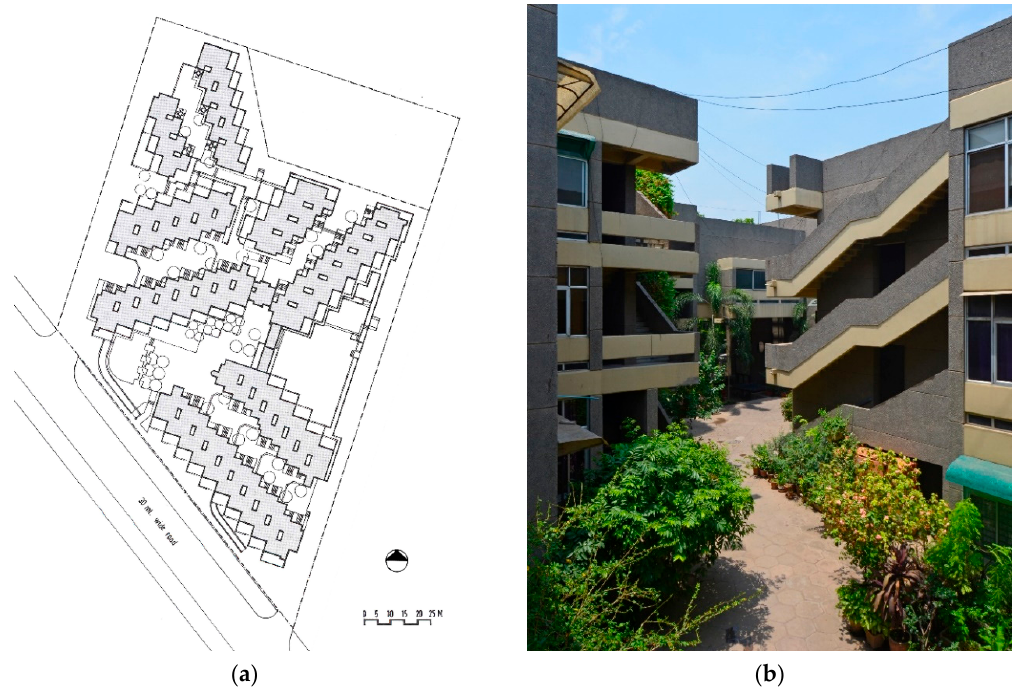
Figure 3. ( a ) Site Plan of Yamuna Apartments with housing blocks placed along four radially-converging streets [19]; ( b ) housing units overlooking the narrow pedestrian streets in Yamuna Apartments (Photo: Author).